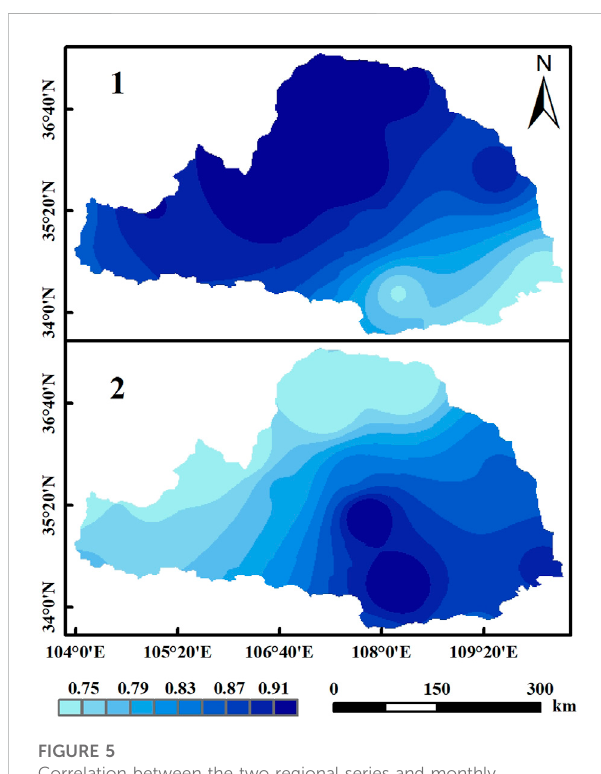
FIGURE 5 Correlation between the two regional series and monthly precipitation series in the different